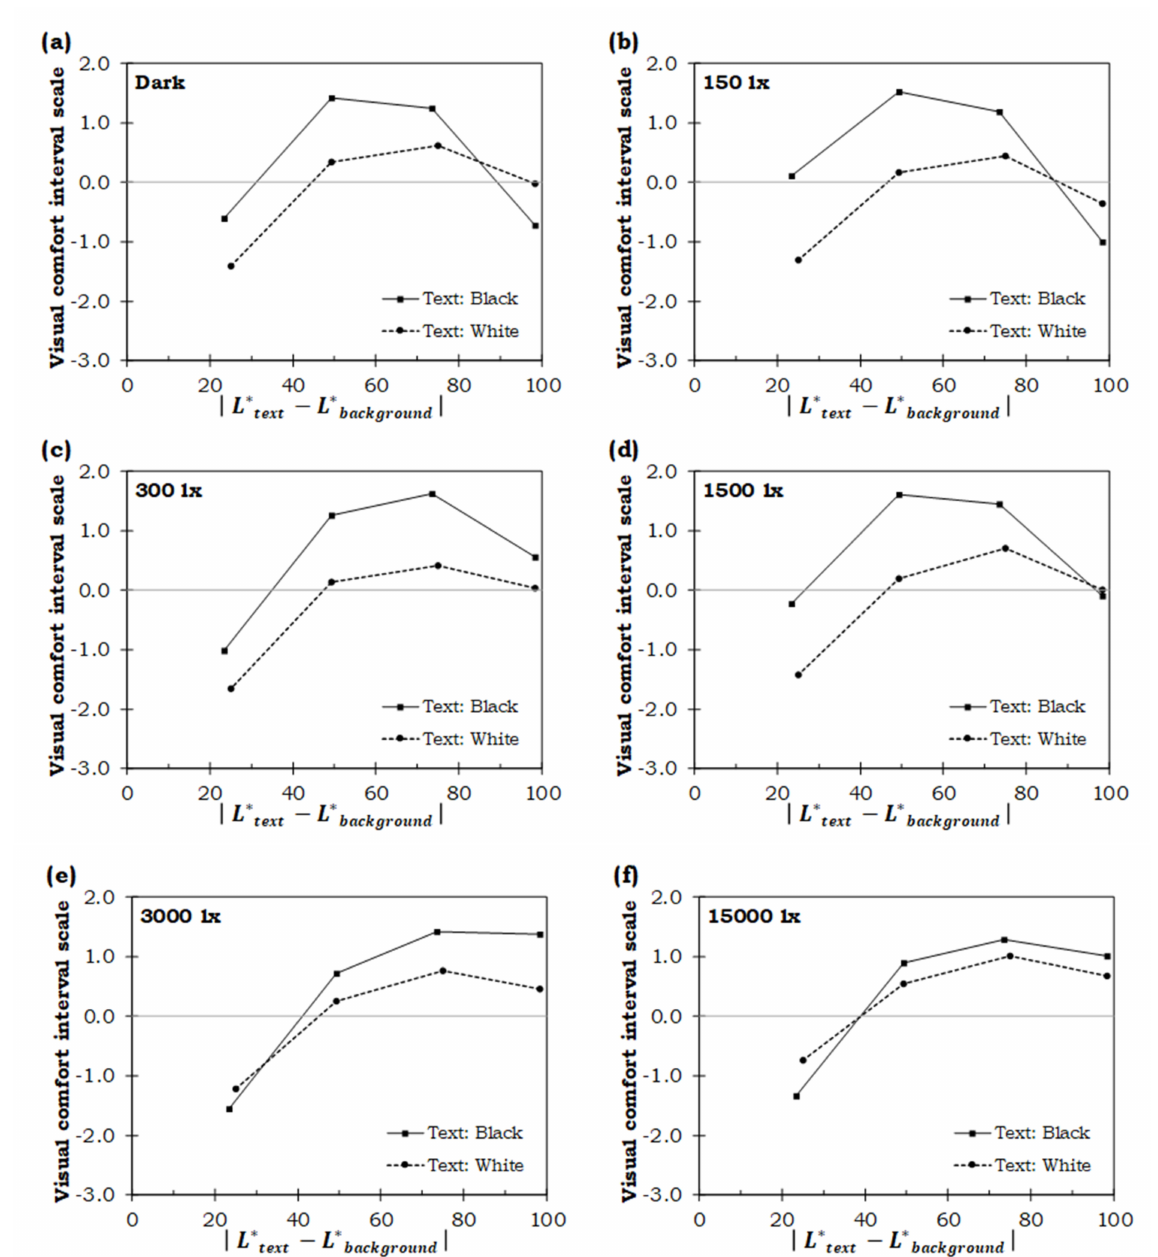
Figure 8. Visual comfort interval scale of the text-background combination with white and black text under six